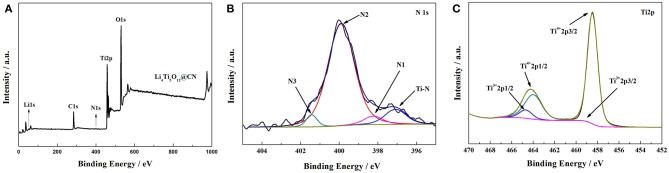
(A) X-ray photoelectron spectroscopy survey spectra of Li4Ti5O12@CN composite, (B) high-resolution XPS spectra of N1s, (C) high-resolution XPS spectra of Ti2p.